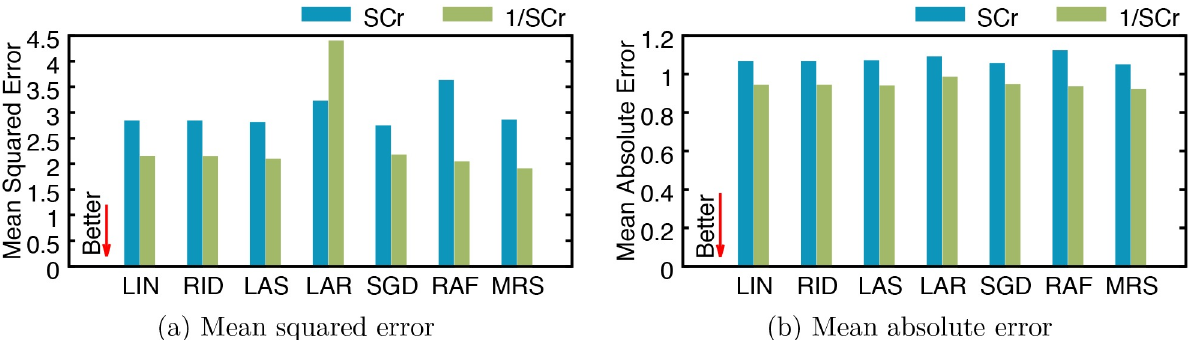
Fig 4. Performance of serum creatinine (SCr) regression by several models using SCr and 1/SCr. (a) mean squared error, and (b) mean absolute error. LIN: linear regression, RID: ridge regression, LAS: lasso, LAR: least-angle regression (LARS), SGD: stochastic gradient descent, RAF: random forest, and MRS: multivariate adaptive regression splines